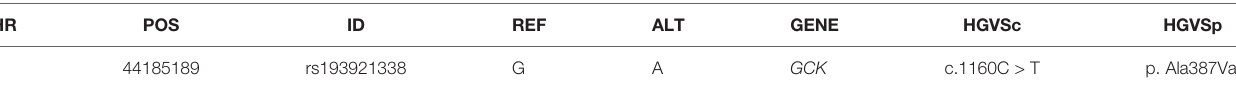
TABLE 3 | Information of candidate pathogenic gene